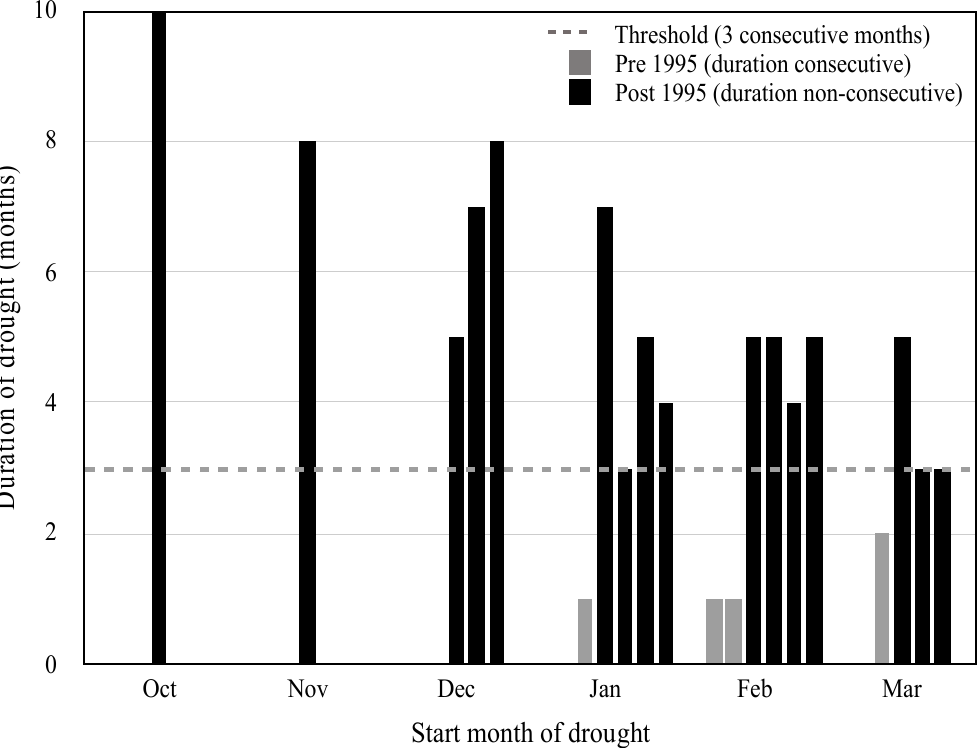
Figure 6. Comparison of the onset and duration of drought during the period 1978–2012 at Forrestdale Lake, shown pre and post 1995. The policy definition of a dry period is ≥ 3 consecutive dry months which must not start prior to April/May. Each bar represents a dry period and respective start month. Drying of the lake prior to 1995 is added as a reference, as the lake dried in the period, but, according to the policy definition, was not considered as drought.